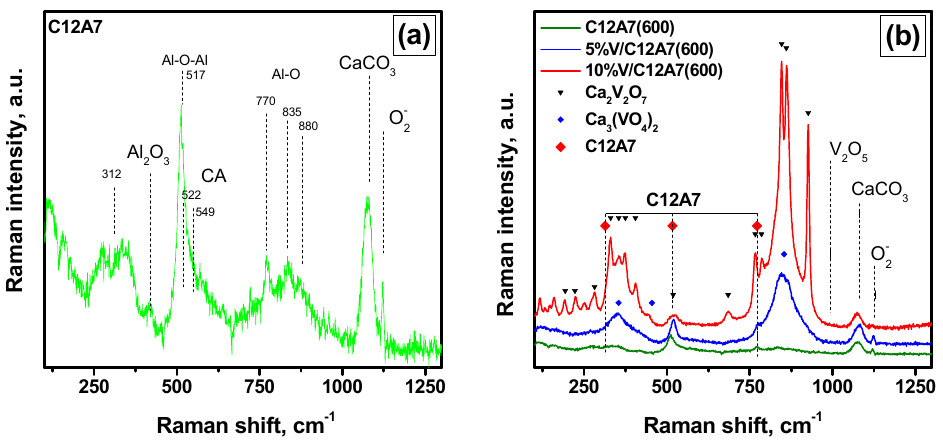
Figure 1. Raman spectra of pure mayenite and V/C12A7 samples calcined at 600 °C: ( a ) detailed spectrum of pure mayenite; ( b ) comparison of all the spectra.